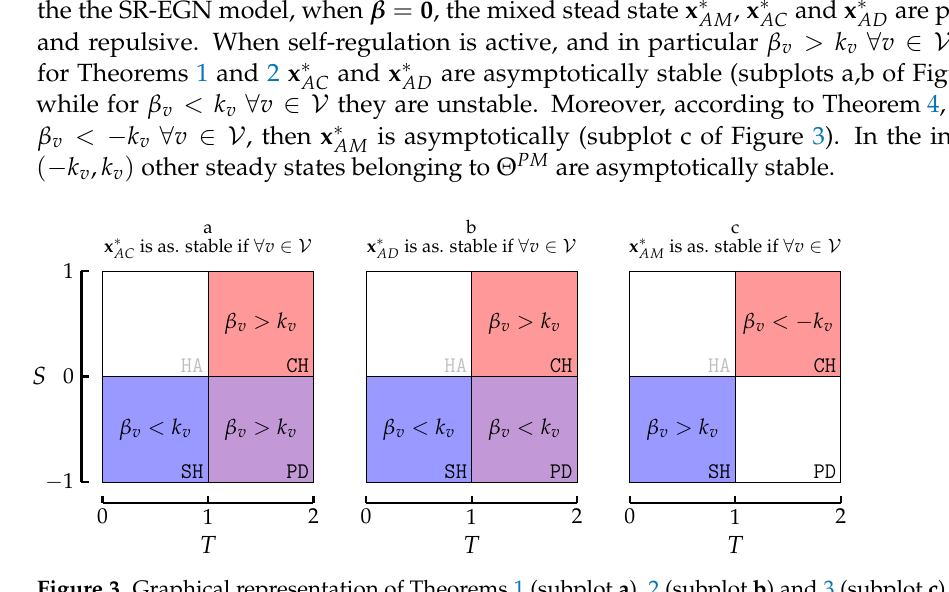
Figure 3. Graphical representation of Theorems 1 (subplot a ), 2 (subplot b ) and 3 (subplot c